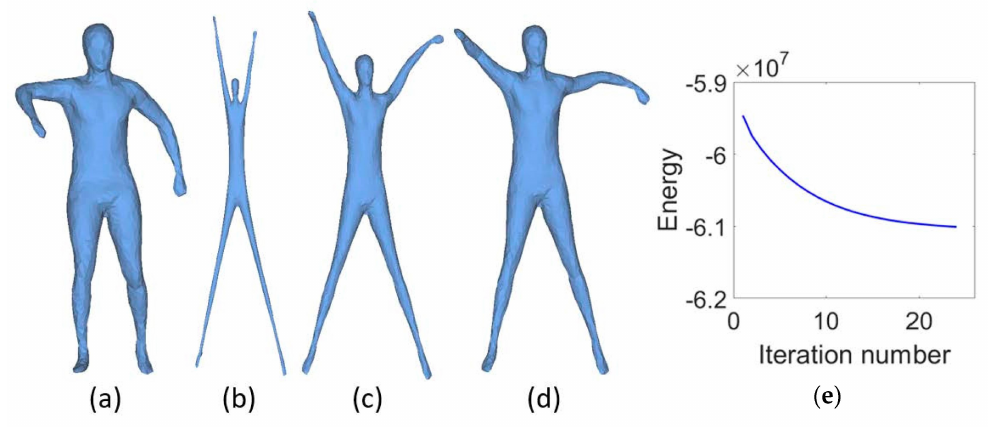
Figure 2. The influences of β . ( a ) is the original mesh. From ( b – d ) are the mesh unfolding results with β = 5 × 10 5 , 1 × 10 6 , 2 × 10 6 , respectively. ( e ) shows the convergence curve of the objective function with β = 1 × 10 6